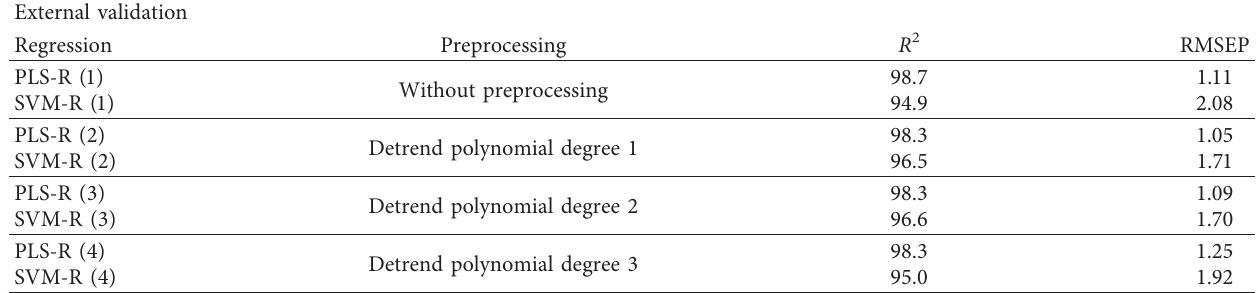
Table 2: Performance of the PLS-R and SVM-R models by external validation using